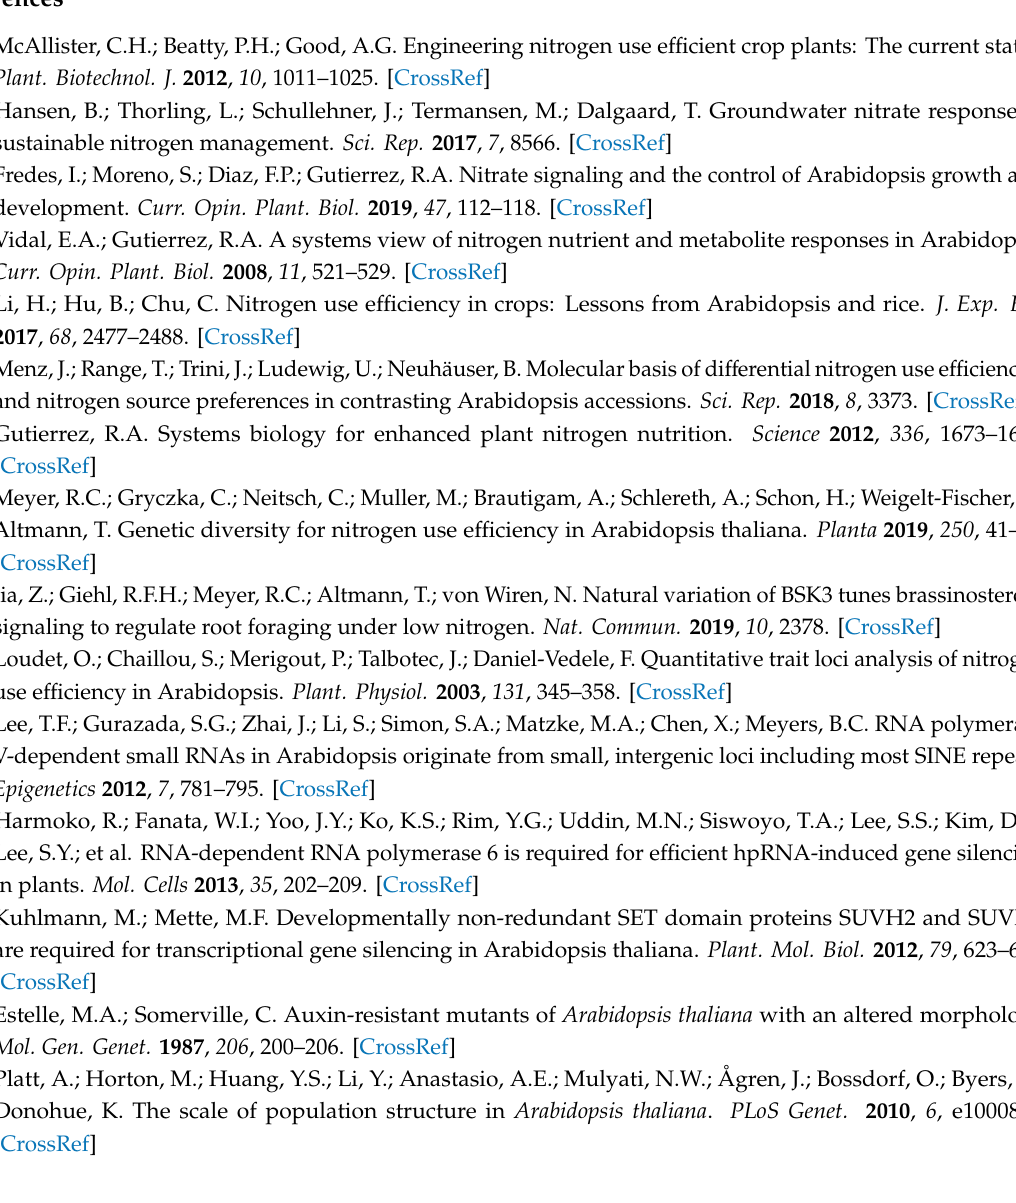
Supplementary Materials: The following are available online at http: // www.mdpi.com / 2073-4395 / 10 / 5 / 636 / s1, Figure S1: Alignment of EDA11 , AT1G55430 and AT1G55440 amino acid sequences. Figure S2: Patterns of DNA methylation in the QTL region. Figure S3: Nitrogen content in vermiculite substrate. Figure S4: Methylation pattern in suvh2 / 9 and rdr2 / 6 mutant plants. Figure S5: Promotor sequence of Appt-1 AT1G55430 . Figure S6: Gene expression related to triacylglycerol synthesis. The transcription of genes involved in synthesis of DAG / TAG under nitrogen deficiency. Table S1: Information about accessions used in this study. Table S2: Information about crosses prepared for mixed Recombinant Inbred Lines (mRILs). Table S3: Information about markers used in GWAS for mRILs. Table S4: Primers and location of SNPs for SNaPShot technology. Table S5: Primers used in this study. Table S6: 2-factor ANOVA of fresh weight and root length under di ff erent N